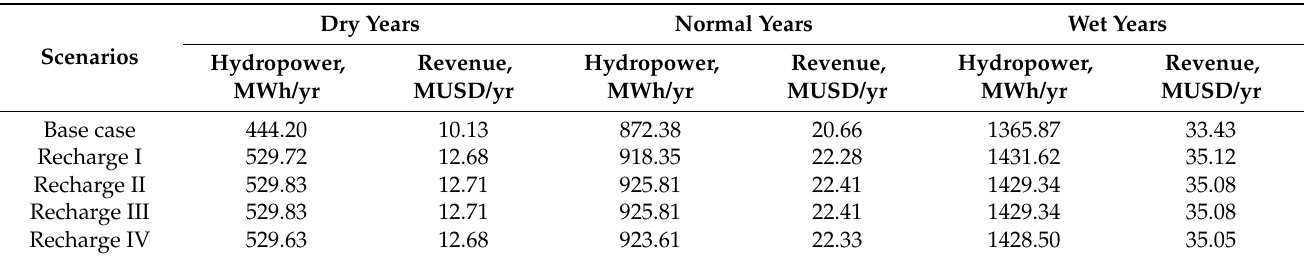
Table 4. Annual average hydropower generation and revenue (million US dollars, MUSD) over different water years.